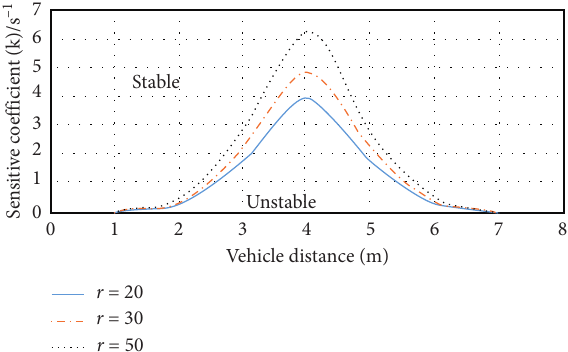
Figure 4: Medium linear stability conditions of the TOV car- following